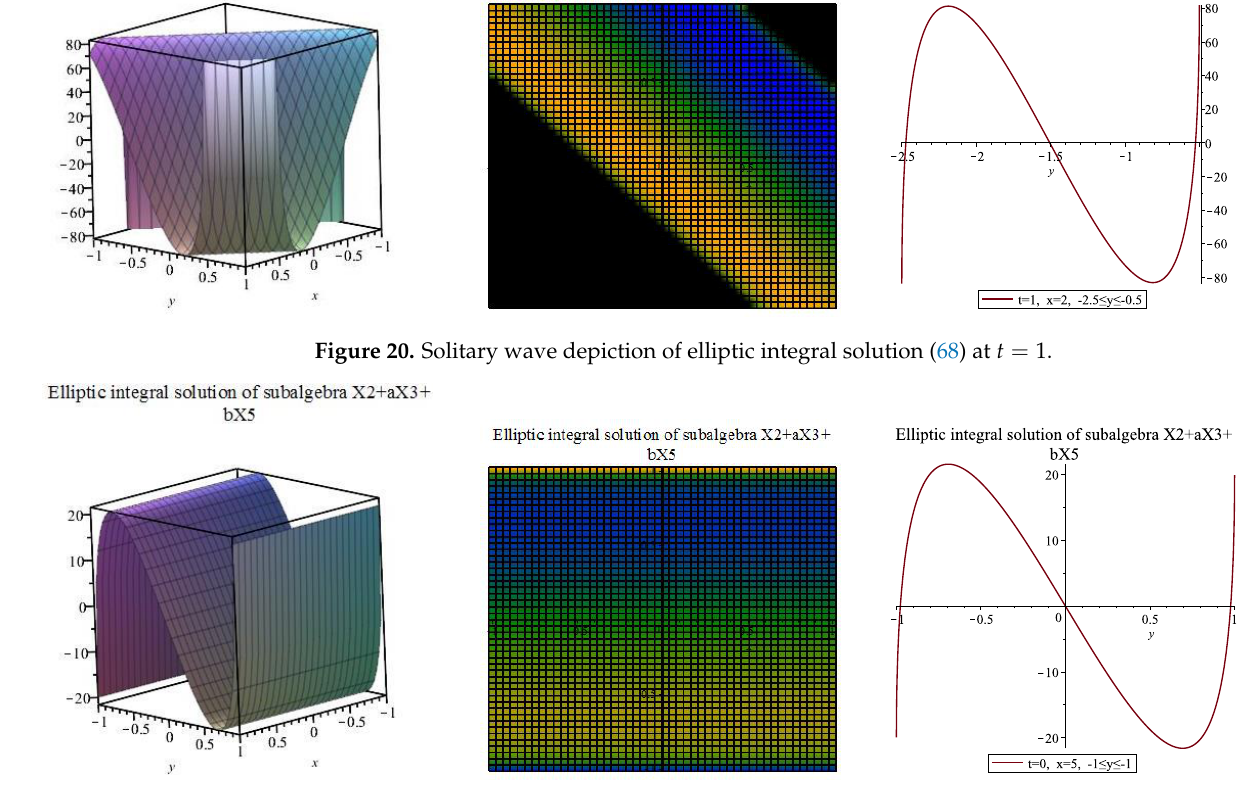
Figure 21. Solitary wave depiction of elliptic integral solution (68) at t =